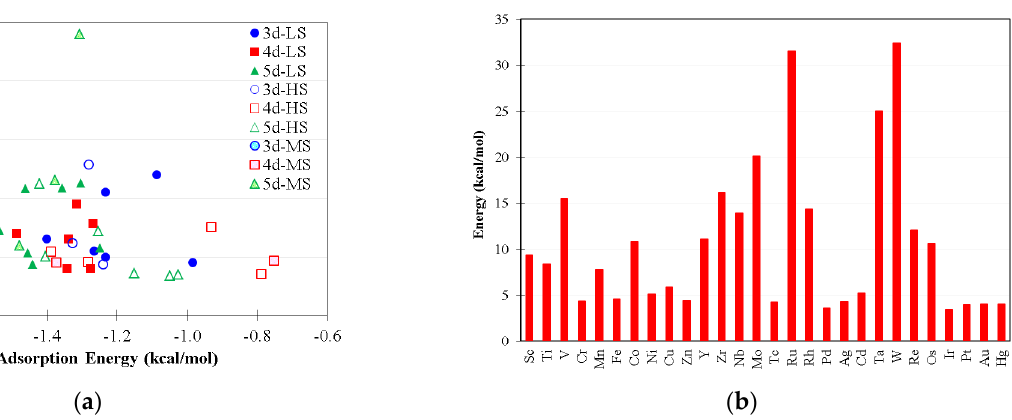
Figure 2. ( a ) The H 2 adsorption energies and bond lengths of LMCl 2 (H 2 ) intermediates where basis set superposition errors are corrected; LS, MS, and HS denote the low-spin, high-spin, and medium spin states of complexes, respectively (see Table S3); ( b ) The CO 2 desorption energies of low-spin LMCl 2 (CO 2 ) intermediates.